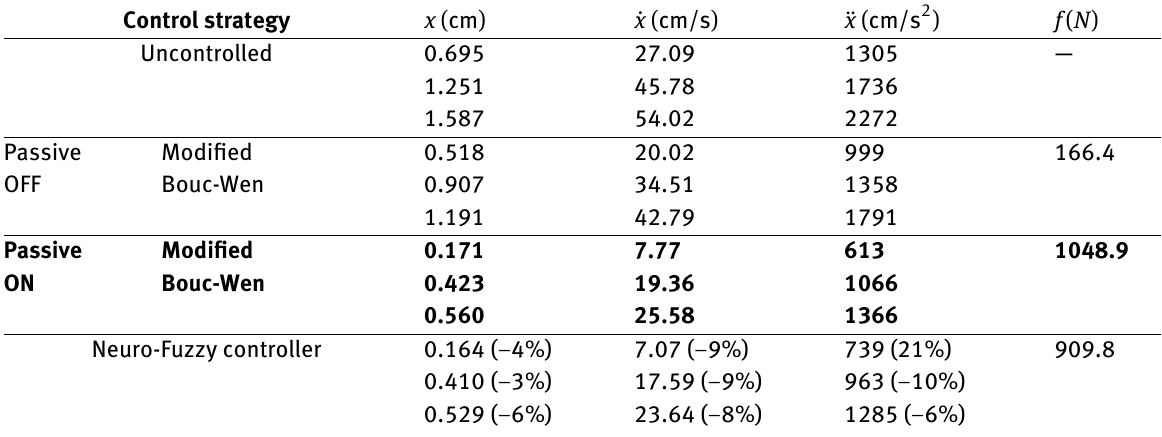
Table 2: Peak responses under the time-scaled El-Centro